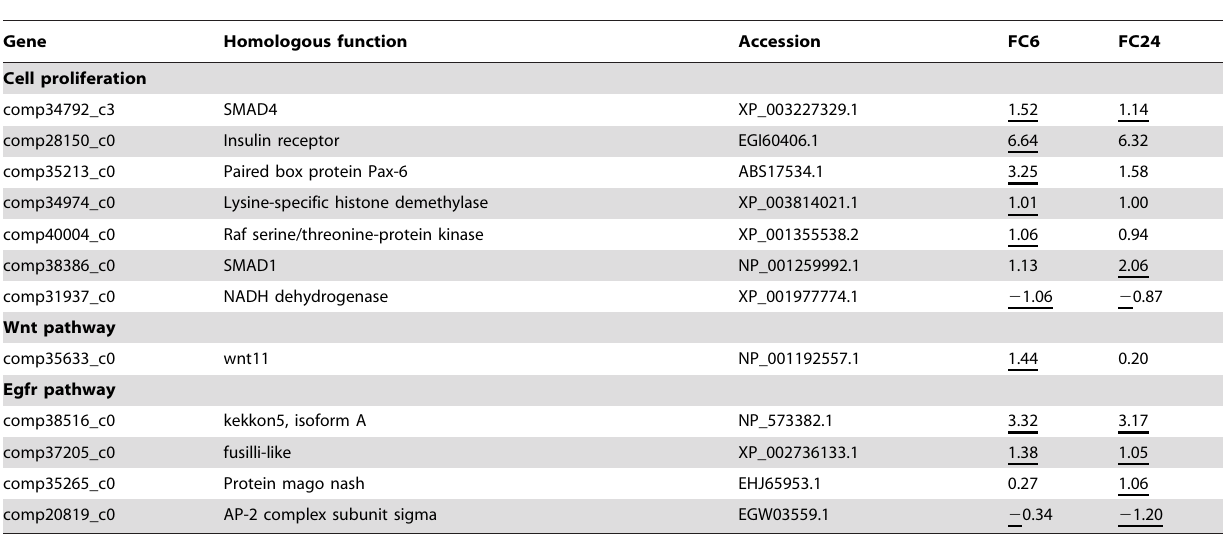
Table 3. Genes involved in cell proliferation and related pathway.